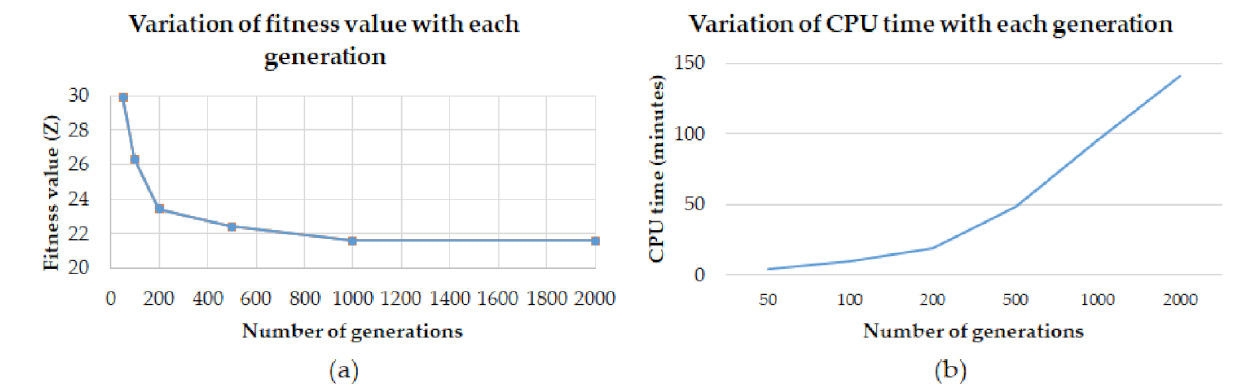
Figure 9. ( a ) Change in fitness value; ( b ) Variation in CPU time.